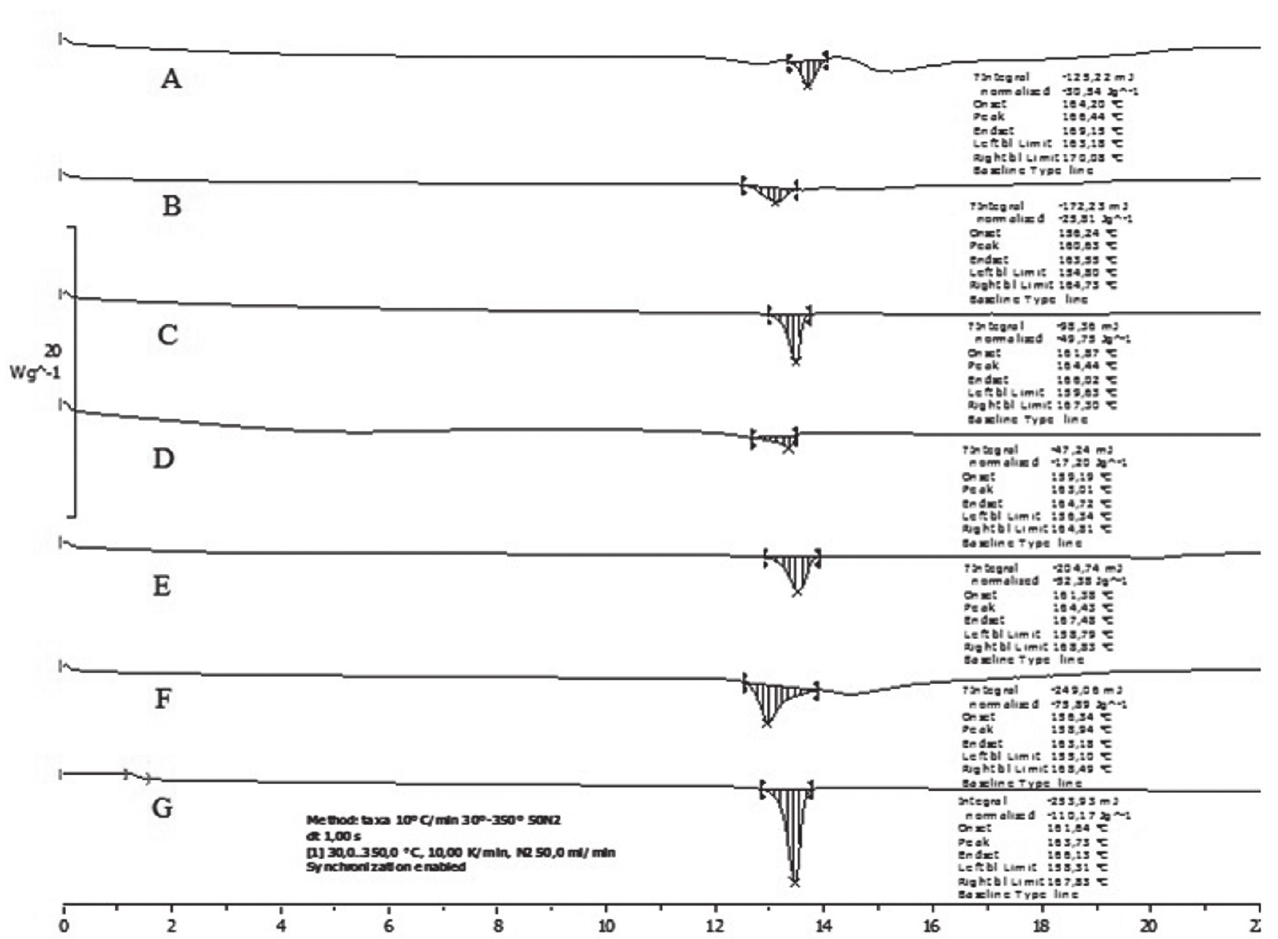
FIGURE 1 - Thermal analysis of DSC A) Final formulation of PROP; B) PROP + Placebo of the pellets; C) PROP + talc; D) PROP + PVP K30; E) PROP + HPMC; F) PROP + EIS; G)